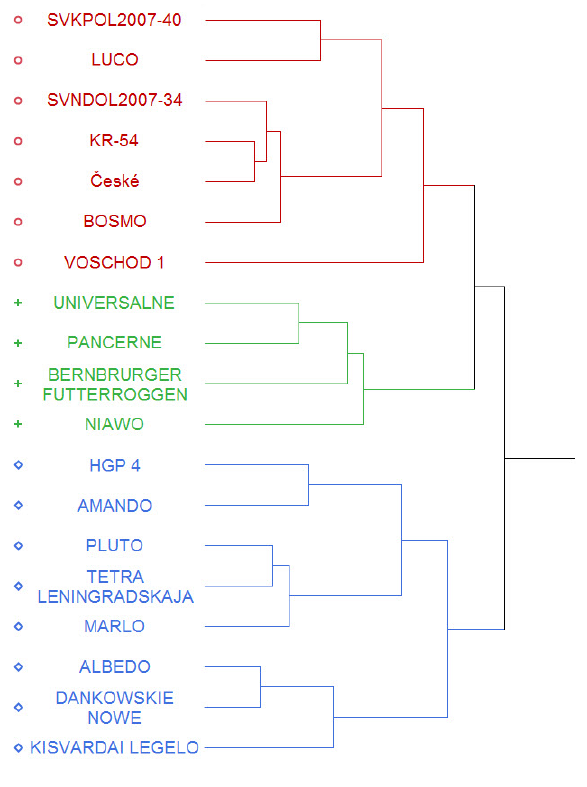
Figure 3: Cluster analysis presenting relationships among 19 rye